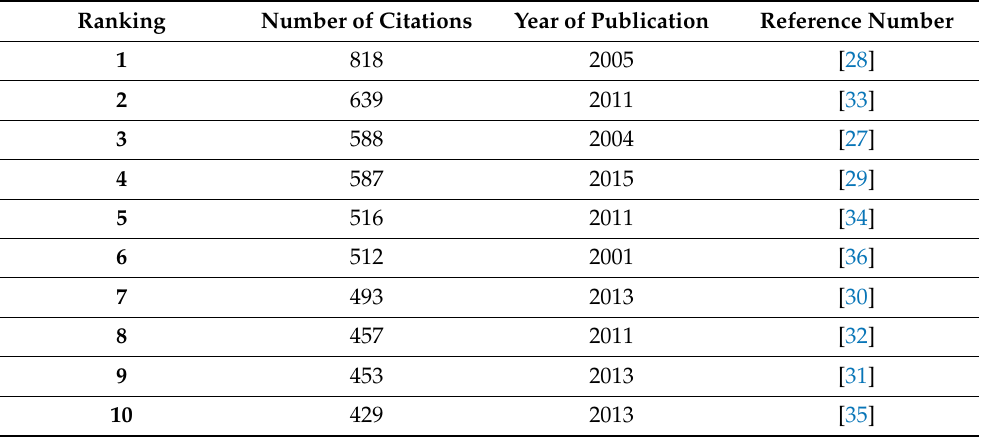
Table 1. Frequently cited research on EVs in Engineering, Electrical, and Electronics fields.